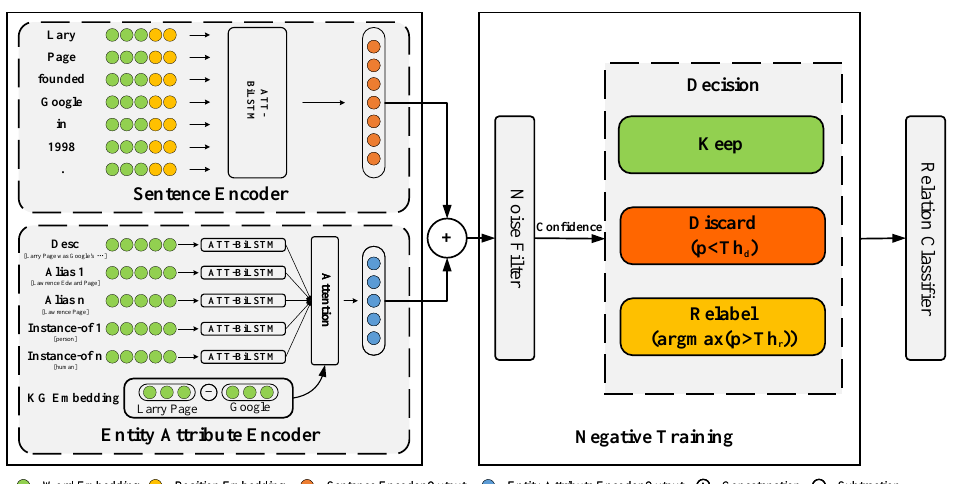
Figure 2. Illustration of our model EANT. In the figure, p denotes the confidence level of the sentence. Th d represents the discard threshold. Th r represents the relabel